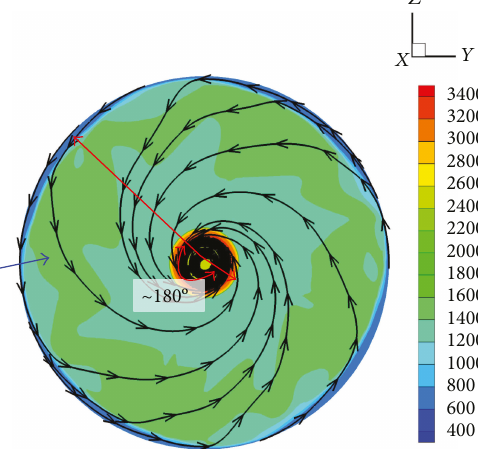
Figure 12: Surface stream trace of the fl ow pattern of Case A X = −